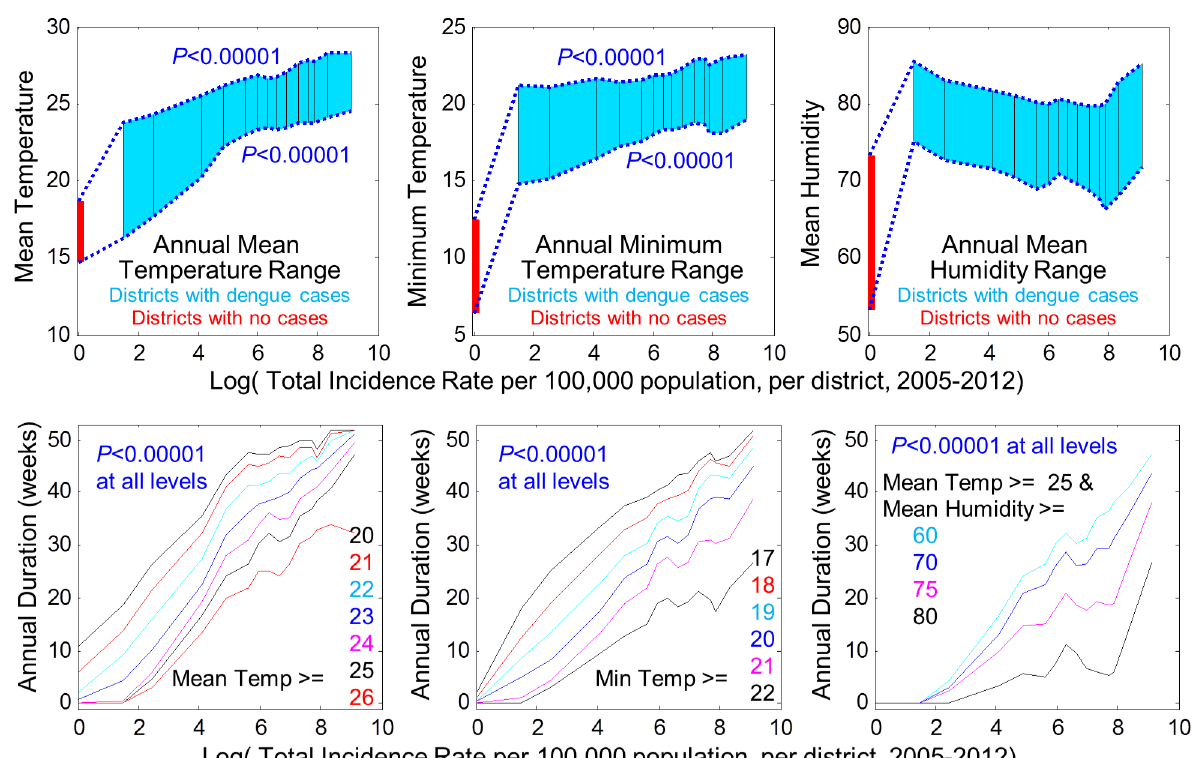
Fig 3. Relationship between weather and dengue incidence magnitude across districts. Top row: Annual temperature and humidity ranges are shown versus district incidence rates, 2005 – 2012. Mean weather ranges are shown for dengue-negative districts and by percentile groups in 5% increments for dengue-positive districts. P-values represent tests of association between weather range and incidence per district. Bottom row: Relationship between incidence and minimum annual duration above specific temperatures is shown in left/center panels. Bottom right: For mean temperature > 25°C, as humidity rises from 60% to 80%, incidence rates accelerate in highest transmission areas, p < 0.00001.